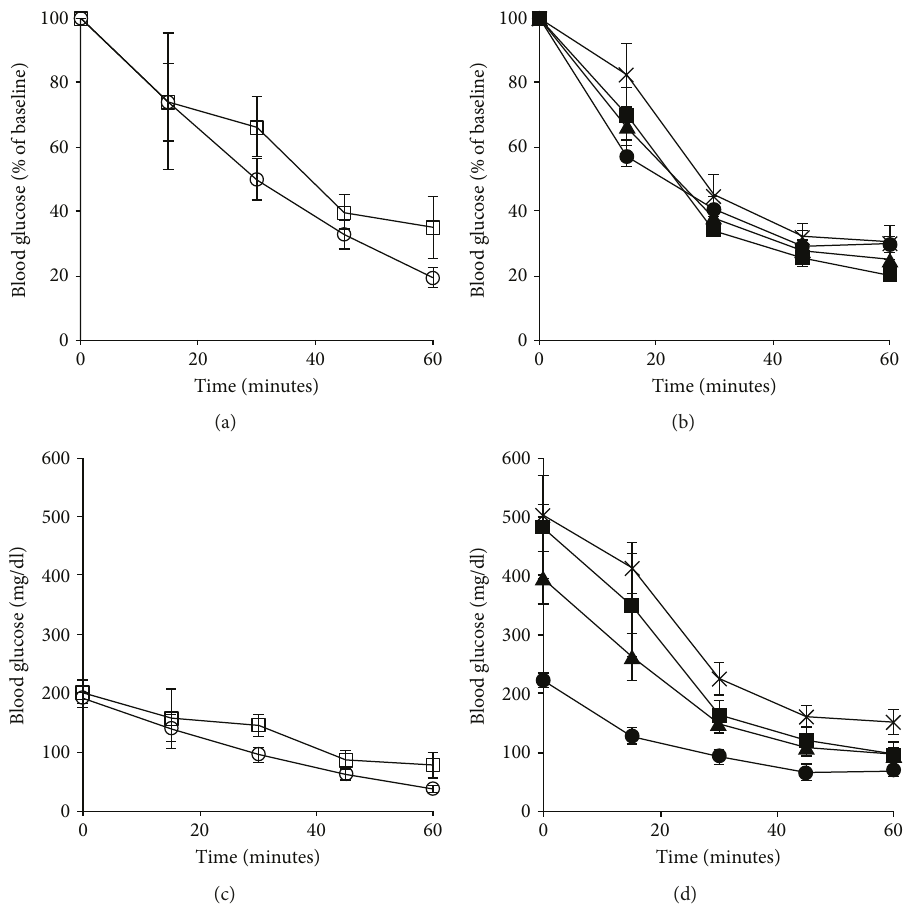
Figure 3: Blood glucose levels, as % of baseline and absolute values, during an ITT in low (a, c) and high (b, d) fat-fed mice treated with three consecutive once-daily doses of vehicle or 30, 50, or 75mg/kg STZ. Treatment groups are denoted as follows: low fat — vehicle, open circles ( n = 4 ); low fat — 30 mg/kg STZ, open squares ( n = 4 ); high fat — vehicle, closed circles ( n = 4 ); high fat — 30 mg/kg STZ, closed squares ( n = 3 ); high fat — 50 mg/kg STZ, closed triangles ( n = 6 ); and high fat — 75mg/kg STZ, × ( n = 3 ). Data are means ± SEM . Table 1: Insulin sensitivity, estimated using QUICKI, in low and high fat-fed mice treated with three consecutive once-daily doses of vehicle, or 30, 50, or 75 mg/kg STZ.